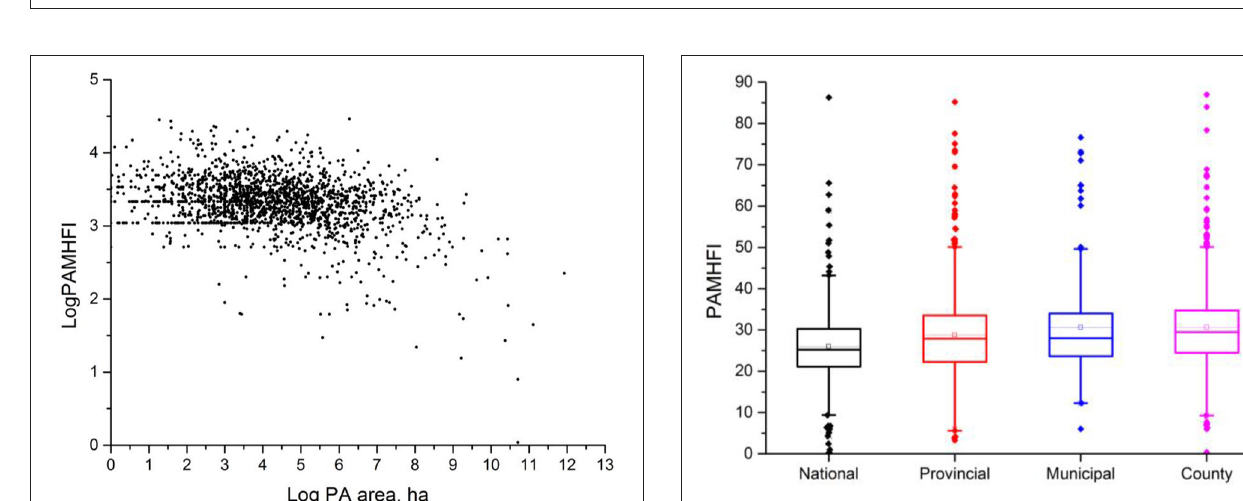
wilderness reserves are significantly lower ( p < 0.001) than for all other PA categories combined ( Figure 4 ). Forest reserves under national governance are significantly ( p < 0.001) more pristine than those at lower governance levels ( Figure 4 ), with